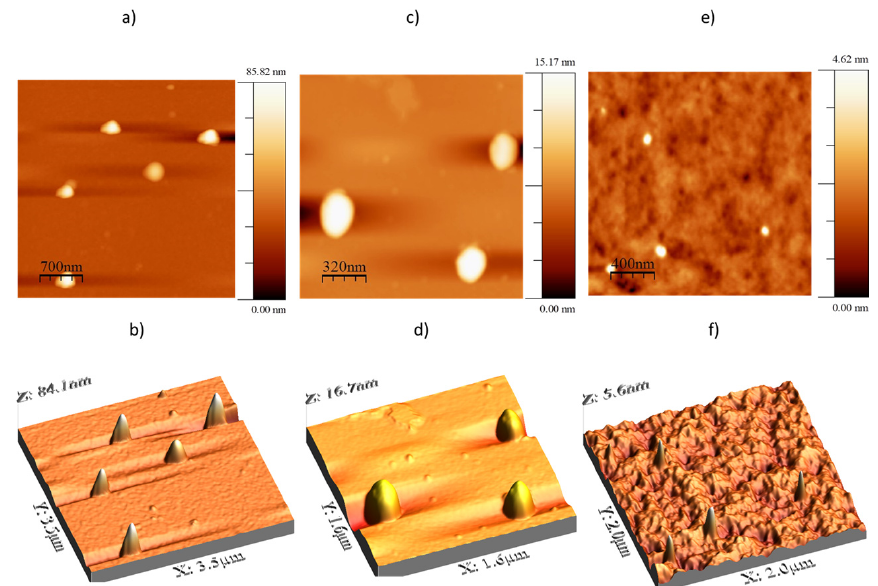
Figure 9. “Height” image and “3D reconstruction“ from AFM of almost spherical aggregates obtained from six-arm star block copolymers on a mica substrate ( c = 0.02 mg/mL): ( a , b ) Sample (PVAc 22 - b -PNVCL 11 ) 6 , Entry 1, Table 4; ( c , d ) Sample [PVAc 30 - b -(PNVCL 28 - co -PNVP 17 )] 6 , Entry 2, Table 4; and ( e , f ) Sample [PVAc 17 - b -(PNVCL 10 - co -PNVP 7 )] 6 , Entry 3, Table 4.